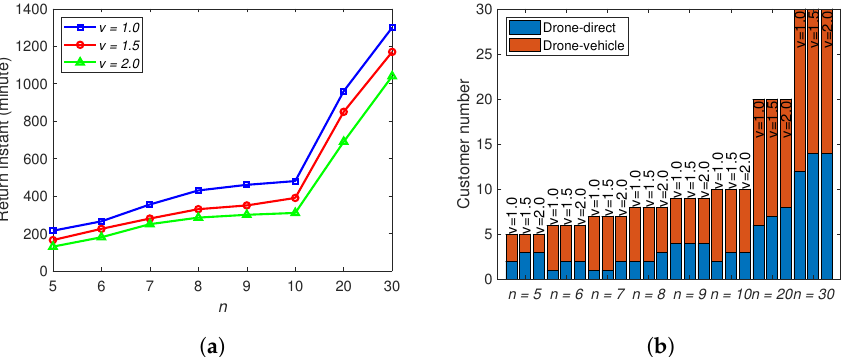
Figure 9. ( a ) The influence of v . ( b ) The number of customers served by different delivery schemes for different v